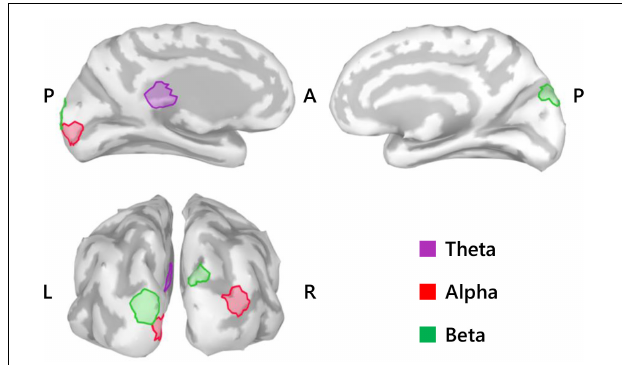
FIGURE 3 | Summary of SPM results ( N = 20). Medial view (top) and posterior view (bottom left) cortical maps highlight the significant clusters (50 voxels) for the theta activity interaction between role and condition, the alpha activity main effect of role, and the beta activity main effect of role. L, left; R, right; A, anterior; P, posterior.